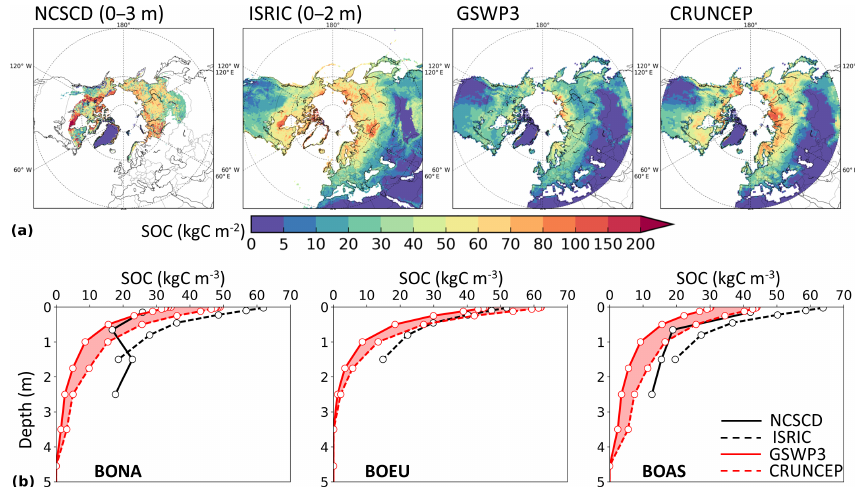
Figure 21. Soil organic carbon from the GSWP3 and CRUNCEP-forced simulations compared with the two inventory datasets NC- SCD (Hugelius et al., 2013) and SoilGrids, averaged over the period 2000–2007. (a) Spatial distribution (kgCm − 2 ). (b) Vertical profiles (kgCm − 3 ) averaged over the three high-latitude sub-regions (shown in Fig. 2a). Since NCSCD does not encompass the whole domain, only grid cells with available data in NCSCD are averaged for BONA and BOAS so that the four vertical profiles are comparable, while for BOEU, NCSCD is not shown, as it has few data in this